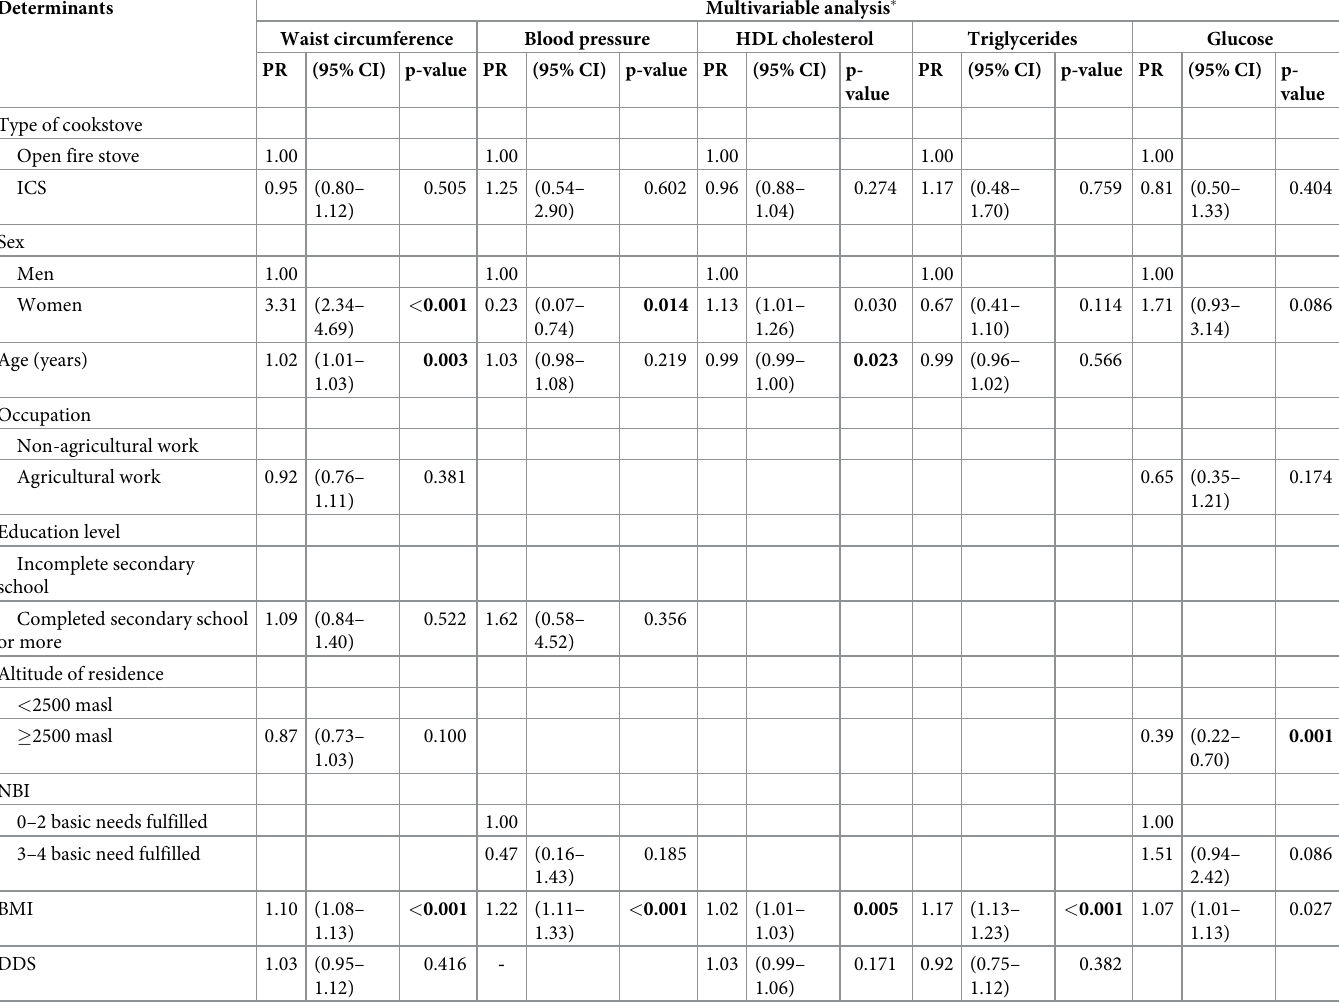
Table 4. Multivariable analysis of the determinants of five components of metabolic syndrome in adults of the provinces of San Marcos and Cajabamba, Caja-